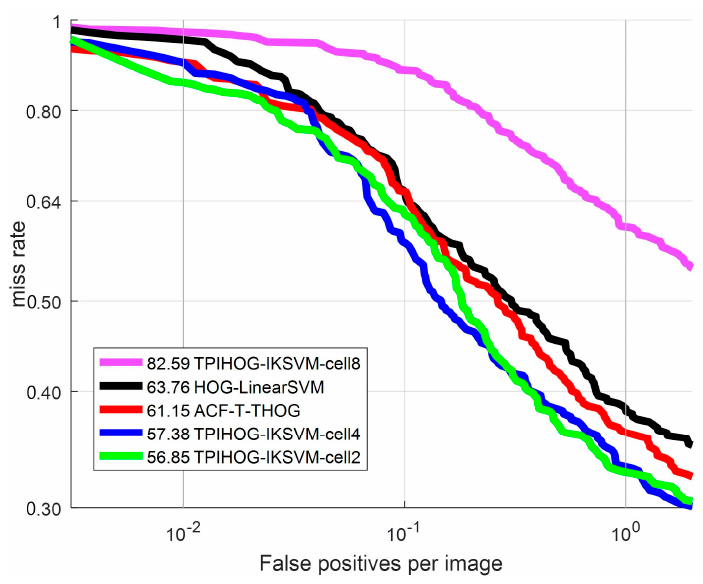
Figure 16. ROC curve: Comparison of classifiers with different cell size. Table 1. Detailed information of